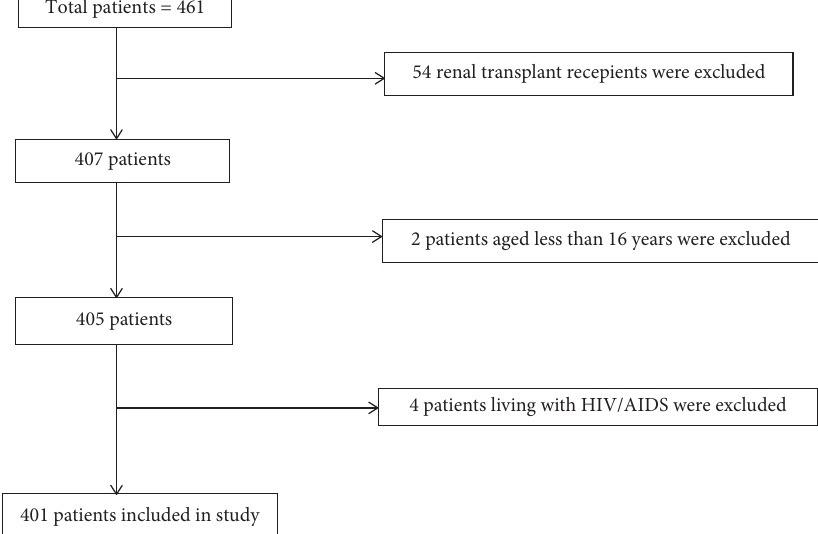
Figure 1: Flowchart showing patients selection based on inclusion and exclusion